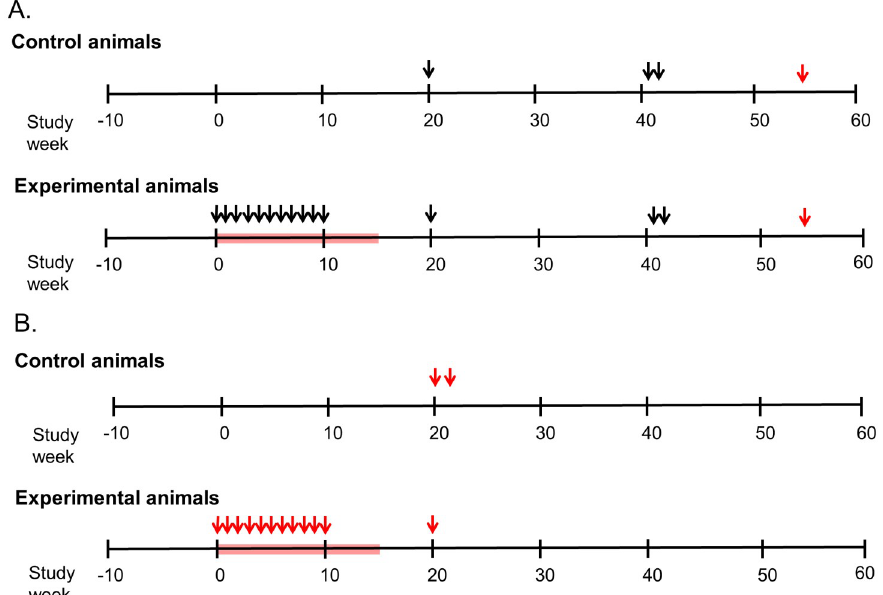
Fig 1. Study design. A . Time schema for immunization of experimental group (n = 4) of female juvenile Macaca nemestrina given ten weekly intravaginal exposures to SIV mne at a TCID 50 of 10 4 (arrows on left) during tenofovir (red block). Controls did not receive tenofovir and were similarly inoculated (n = 2 animals) or given two inoculations